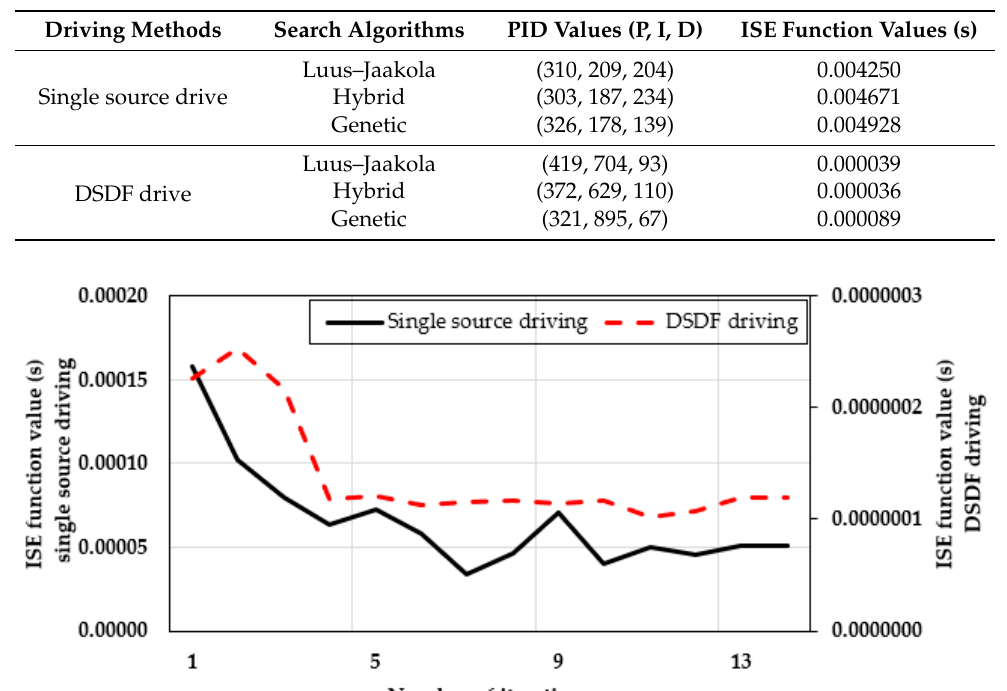
Table 1. Optimal PID parameters and corresponding ISE function values for two driving methods performed with various search algorithms at 2 ◦ /s velocity.